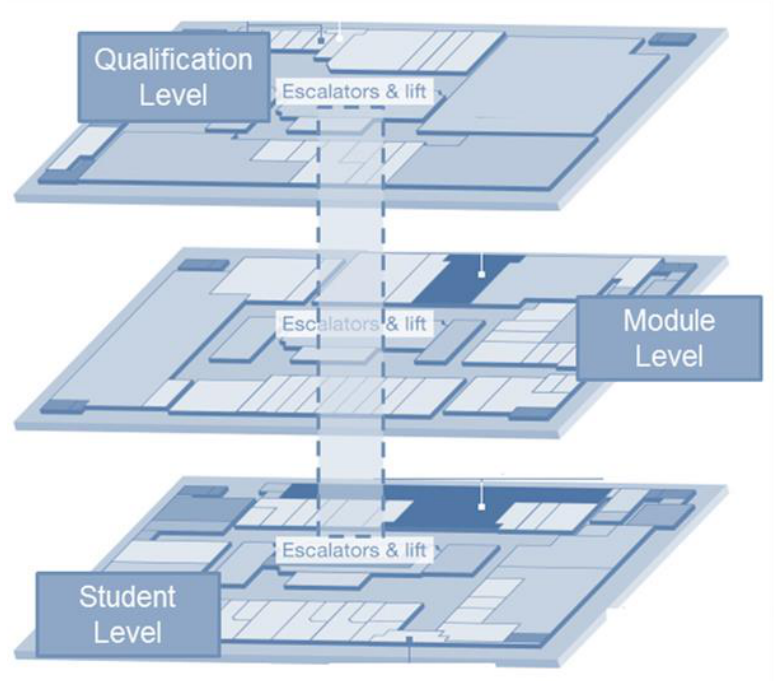
Figure 4. Digital DNA as a multi-storey data department